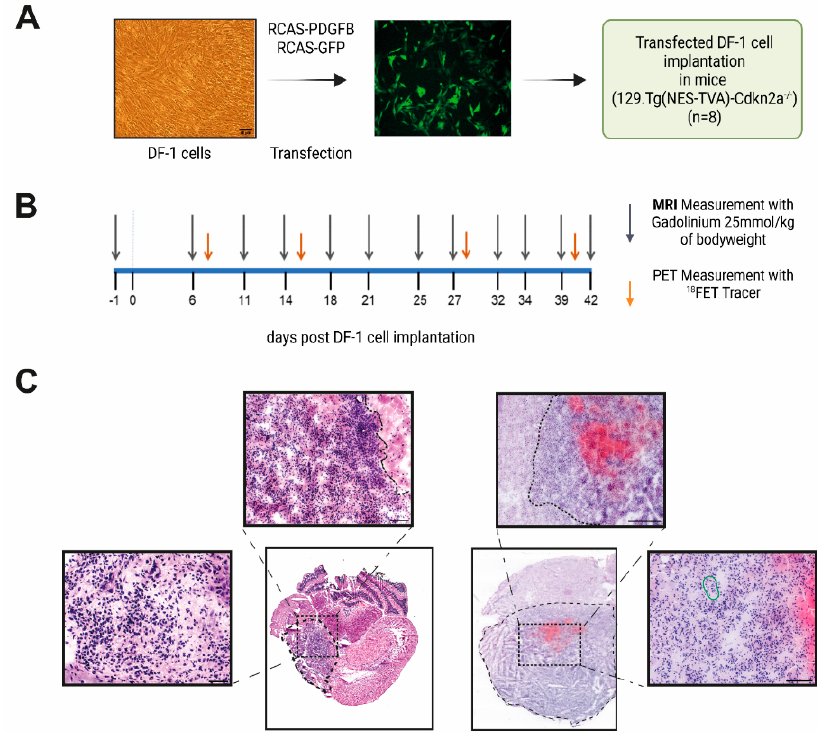
Figure 2. Longitudinal MRI-FET-PET imaging study and H&E staining pattern. ( A ) Schematic overview of experimental design. Brightfield image shows transfected DF-1 cells. Scale bar is 50 µm. Representative picture of DF-1 cells transfected with RCAS-GFP plasmid as transfection control. ( B ) Imaging schedule: day 0 represents the day of implantation of transfected DF-1 cells. ( C ) Representative images of two animals showing glioma formation. Typical aspects of high-grade glioma, such as infiltrating growth behavior, neovascularization (highlighted in green), and cell atypia, are visible. Boundaries of the tumor core area are highlighted with a dotted line. Scale bars are 50 and 100 µ m. ( A , B ) were created with